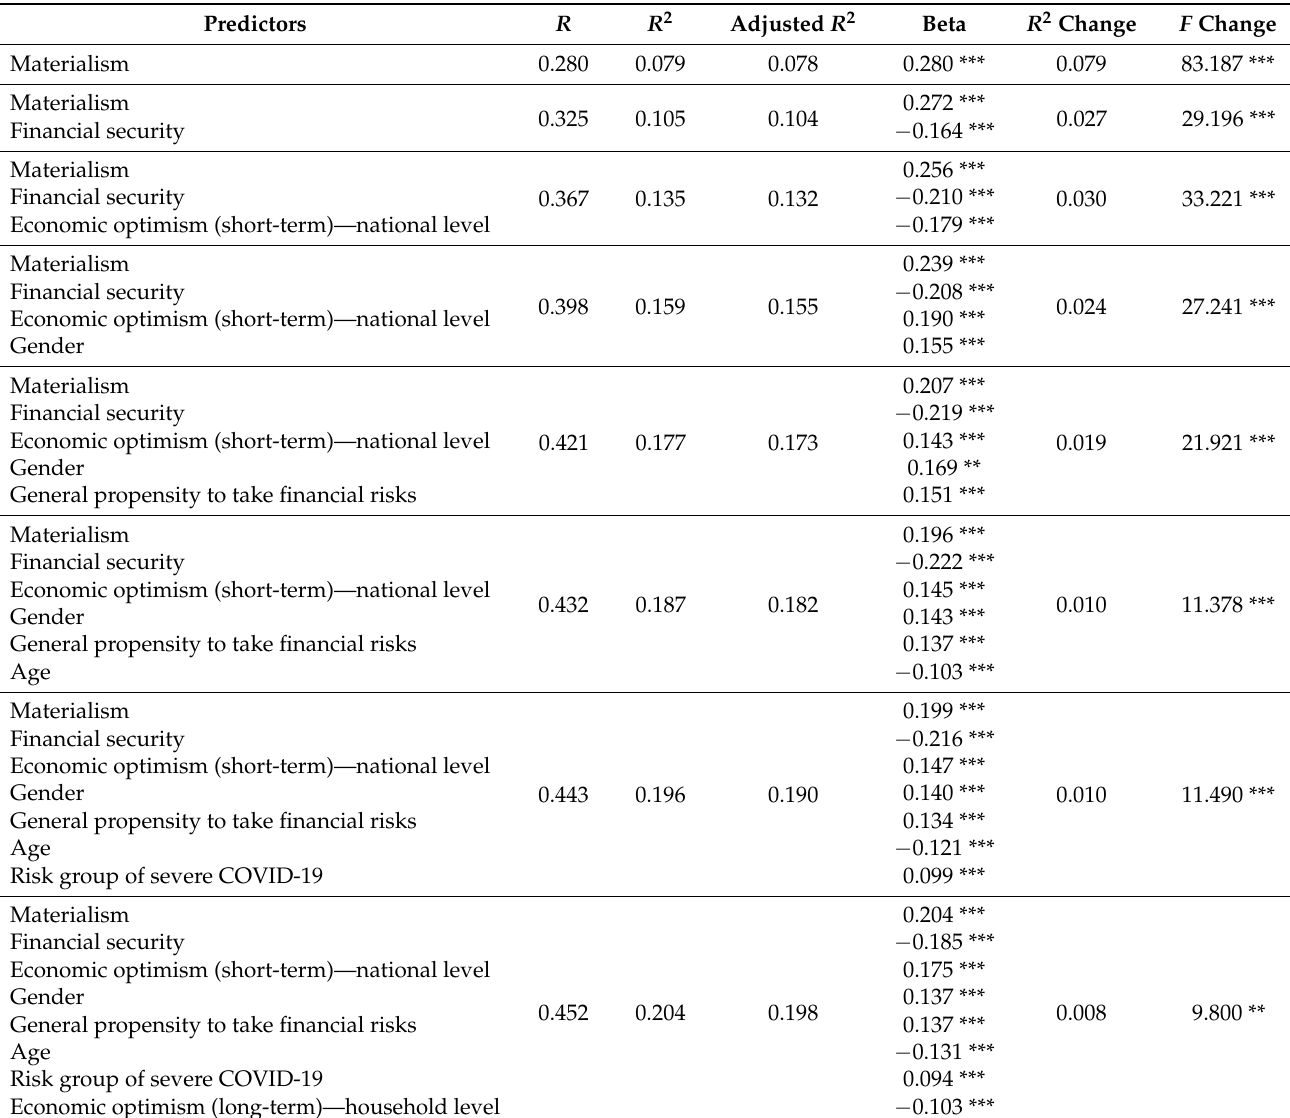
Table A4. Predictors of depression